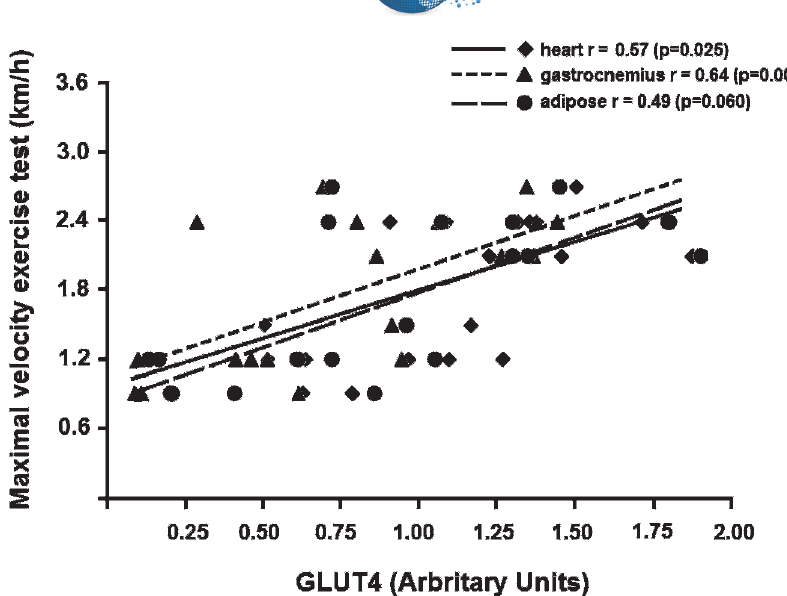
Figure 5 - Scattergram plot of the GLUT4 protein content in the plasma membrane and the maximal velocity exercise test results for all